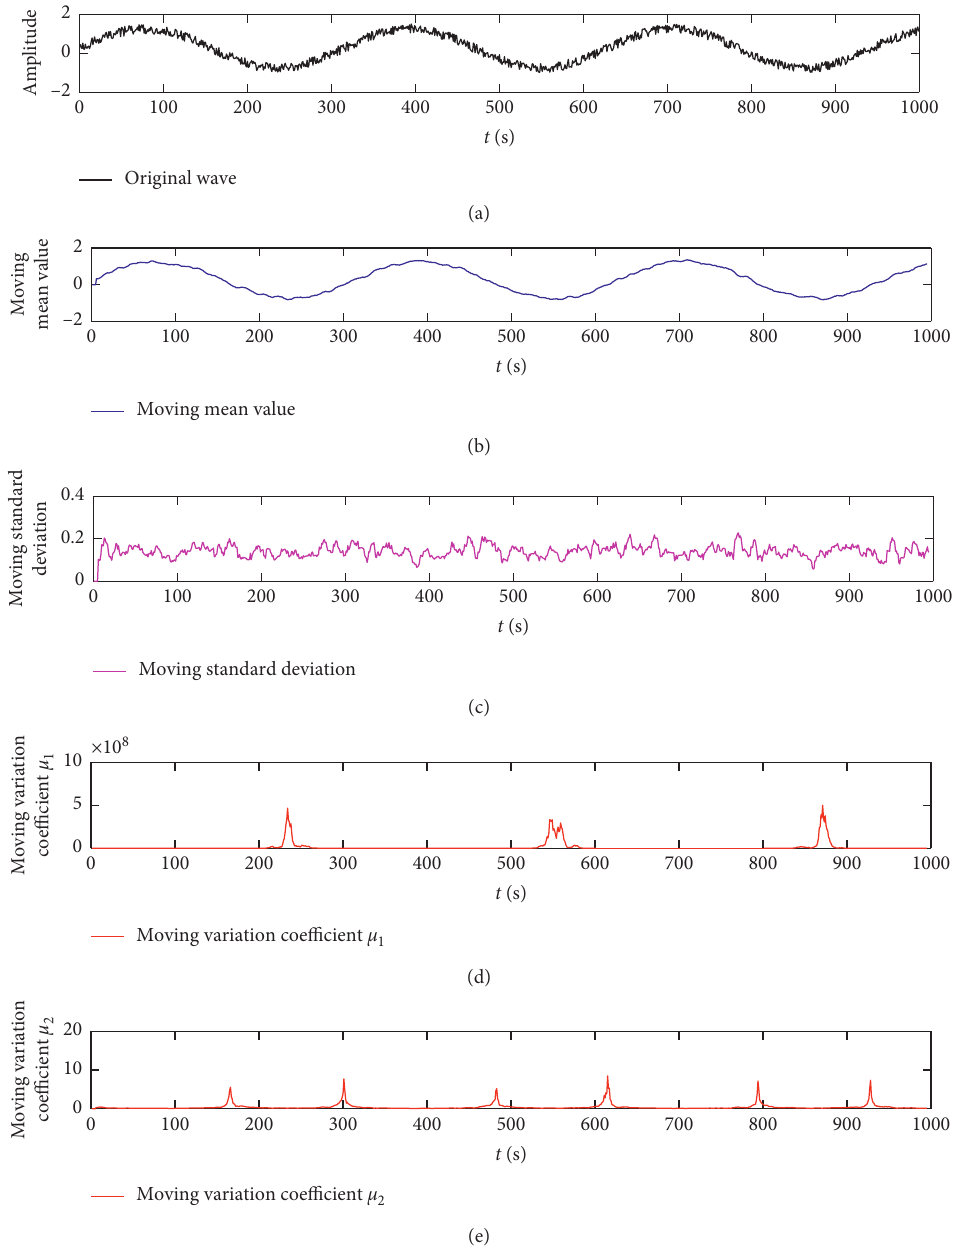
Figure 3: Analysis of sinusoidal superimposed white noise signal based on moving